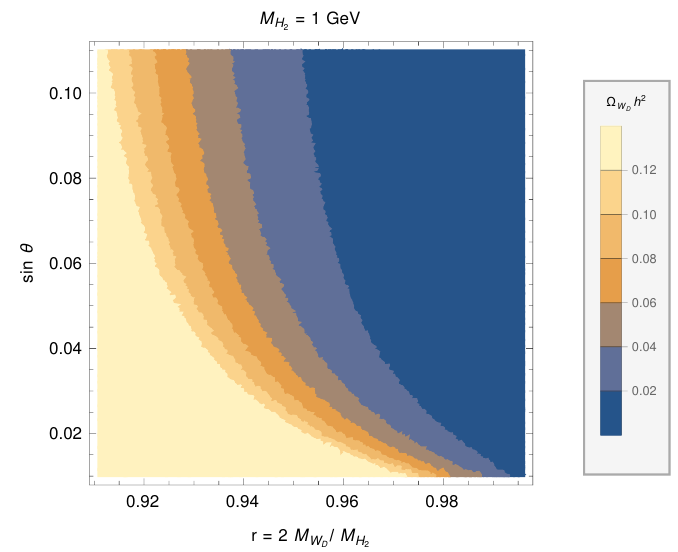
Figure 14 . WIMP DM relic density as a function of the mixing angle sin θ and r ≡ 2 M W that quantifies the closeness to the resonance region. The exact resonance point is where r = 1 . For this example, we have set M = 1 GeV. The other relevant parameter is g H 2 g D = 10 − 4 . In order to have a significant amount of WIMP relic density while not overproducing, we need to be near the range of 0 . 92 . r . 0 . 98 for sin θ < 0 . 1 .